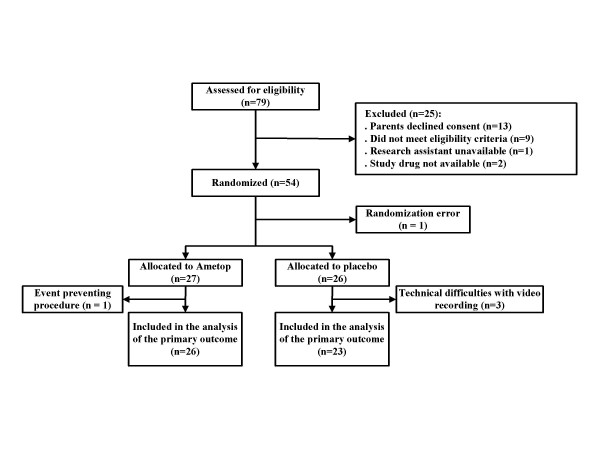
Participant flow through the various stages of the study.